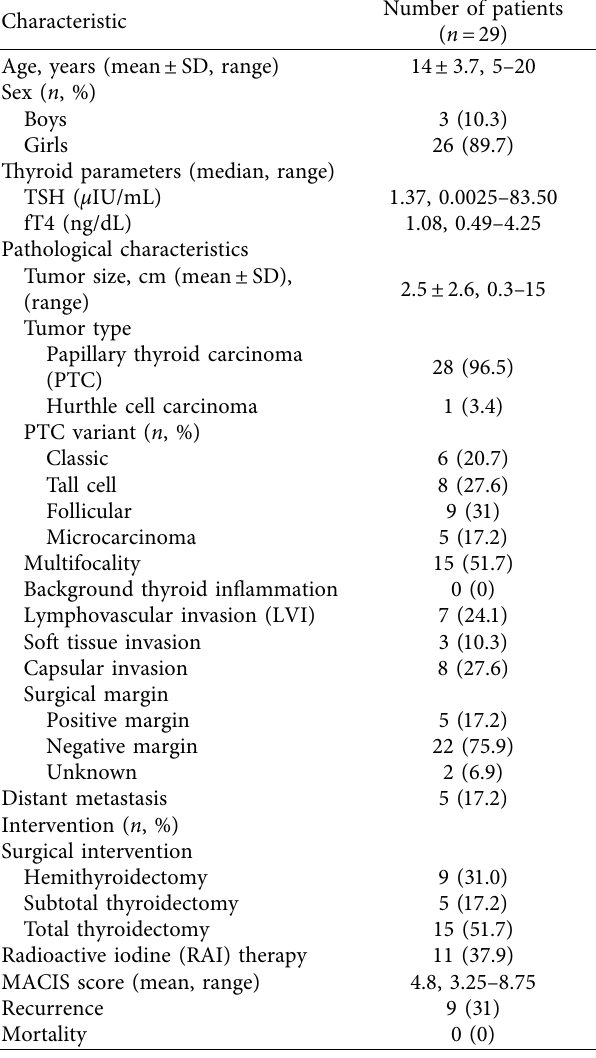
Table 1: Baseline characteristics of study subjects.